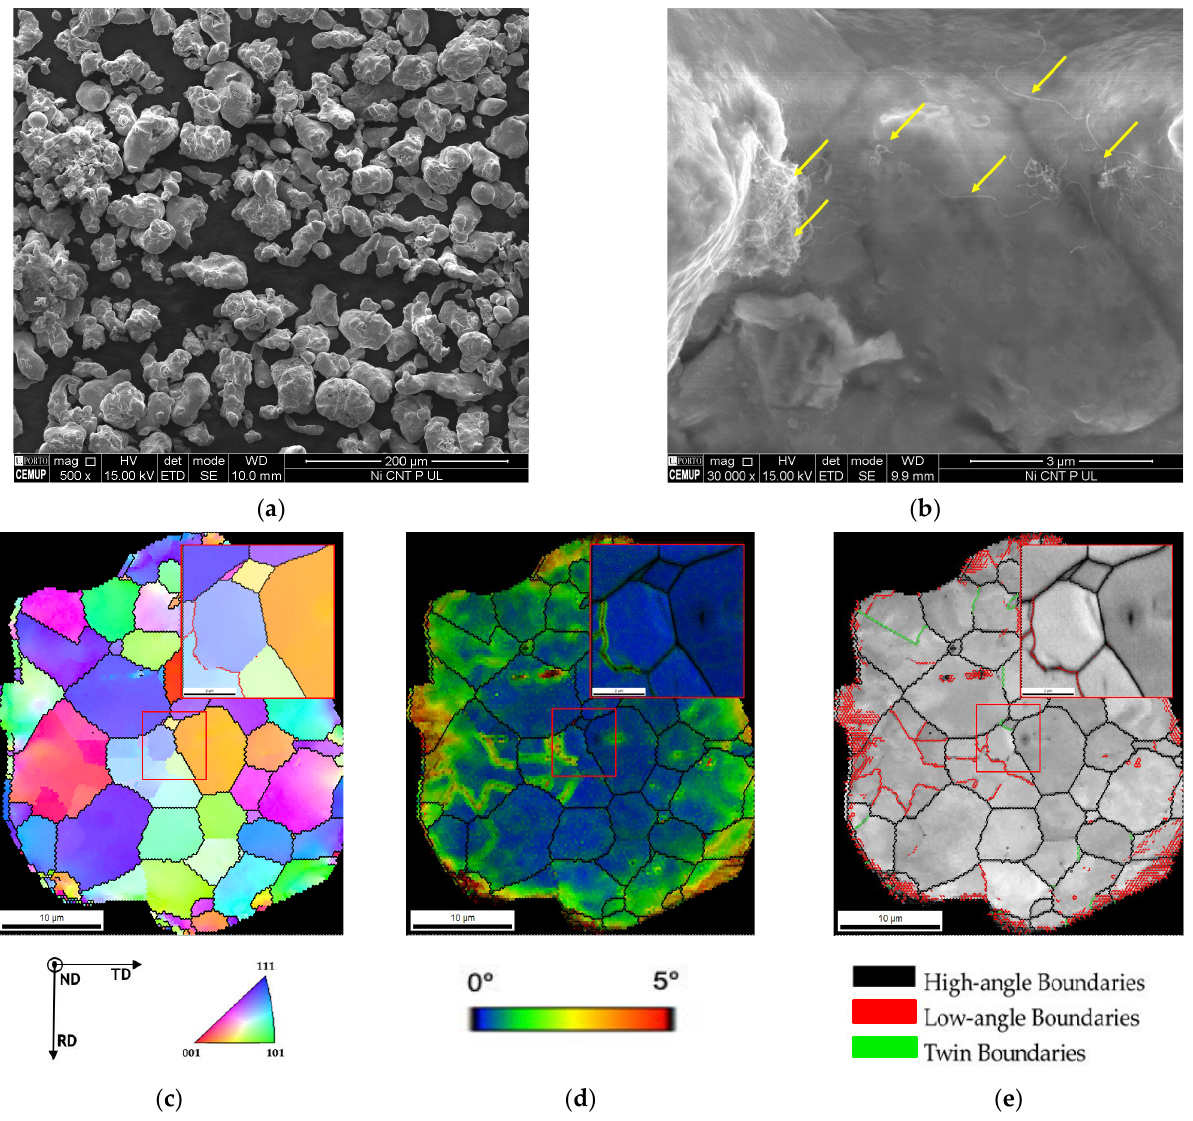
Figure 1. ( a , b ) SEM images of Ni-CNT particles after ultrasonication showing the presence of CNTs (yellow arrows) and ( c ) Inverse pole figure (IPF) map, ( d ) Kernel average misorientation (KAM), and ( e ) image quality (IQ) with high- and low-angle boundaries and twin boundaries delineated.